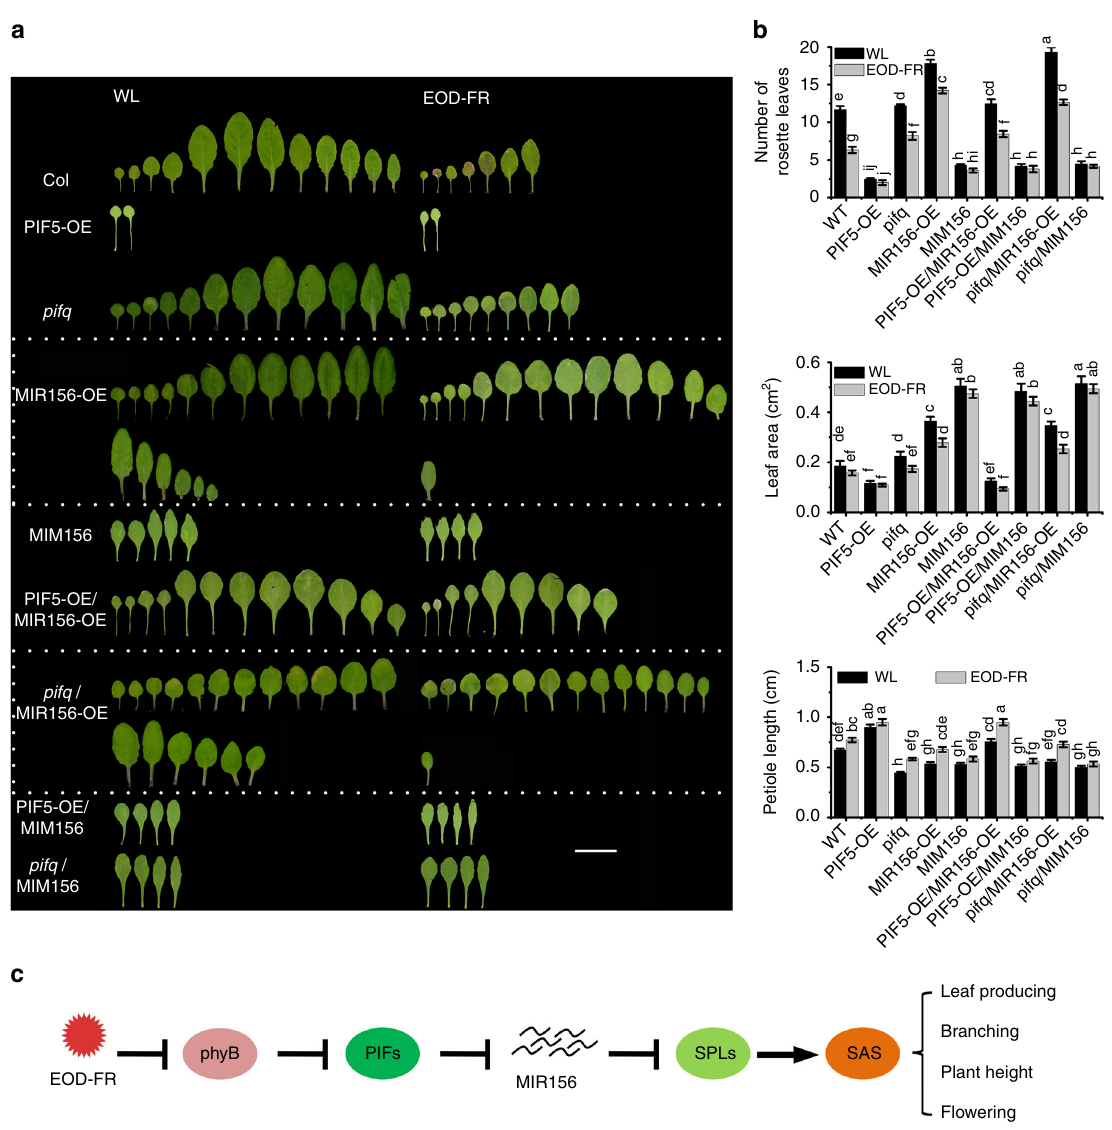
Fig. 5 MIR156s act downstream of PIFs in regulating SAS. a The rosette leaf number, leaf blade area, and petiole length of the fi rst and second leaf of WT, PIF5-OE , pifq , MIR156-OE , MIM156 , and their higher order mutants grown under WL with or without EOD-FR treatment. Eight-day-old seedling grown on Murashige and Skoog agar medium under WL were transferred into soil and treated with EOD-FR for 4 weeks before phenotypic analysis. Bar = 2 cm. b Quanti fi cation of the rosette leaf number, leaf blade area, and petiole length of WT, PIF5-OE , pifq , MIR156-OE , MIM156 , and their higher order mutants grown under WL with or without EOD-FR treatment. Values given are mean ± SD ( n = 12). Letters indicate signi fi cant differences by two-way ANOVA. c Simpli fi ed schematic model depicting the signaling pathway of PIFs and MIR156 to modulate shade-avoidance response in adult Arabidopsis plants. Shade (low R:FR ratios) inactivates phyB and induces a rapid accumulation of PIF proteins. These PIFs then directly bind to the promoters of multiple MIR156 genes and repress their expression, which alleviates the inhibitory effect of MIR156s on their target SPL genes. The activated SPL genes then regulate diverse morphological changes associated with shade-avoidance responses via altering distinct sets of further downstream genes. Arrow : activate; Bar